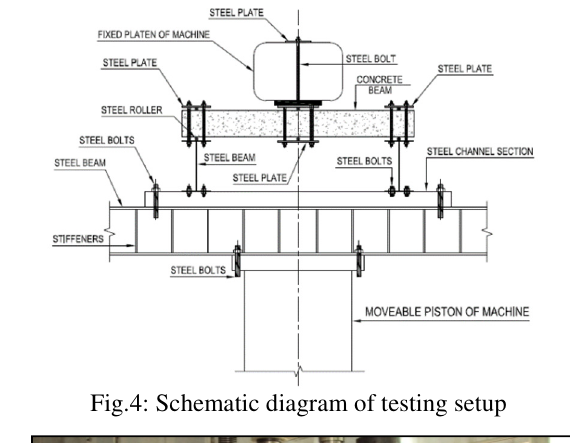
Fig.4: Schematic diagram of testing setup